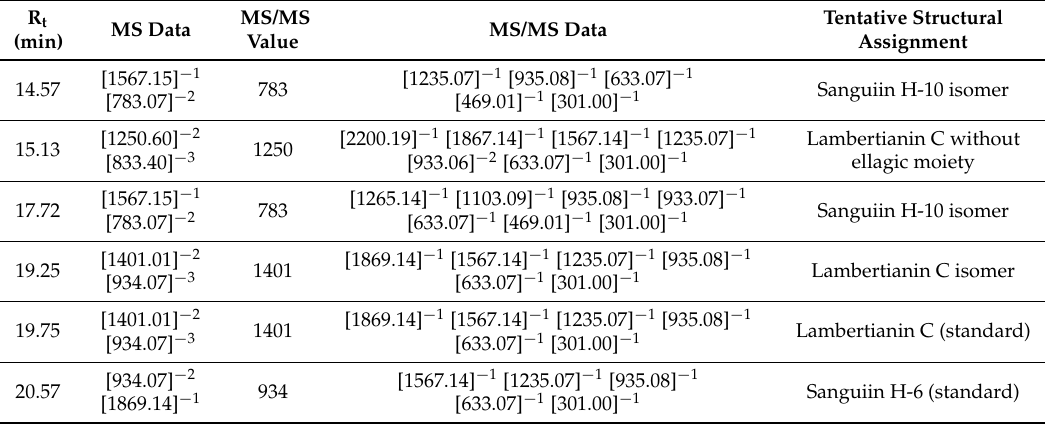
Table 1. LC-MS identification of ellagitannins in the raspberry ellagitannin preparation (REP). R t